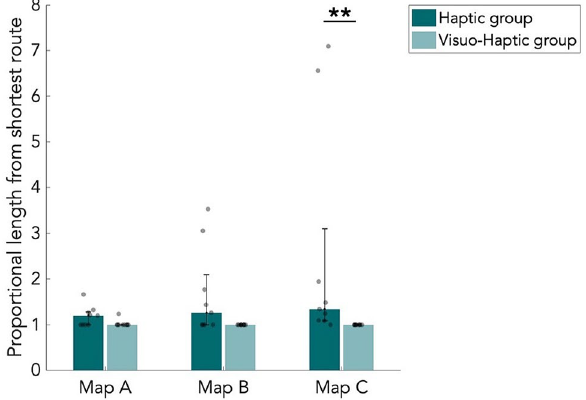
Figure 7. Median length of the navigated route during the navigation task, proportional to the shortest route of the navigation task. For each participant, the mean of the two navigated routes was taken first. Results are shown for all three maps and both the haptic (n = 9) and visuo-haptic group (n = 9). Error bars indicate the 25th and 75th percentiles. Grey dots are individual data points. ** p < 0.01, corrected for multiple